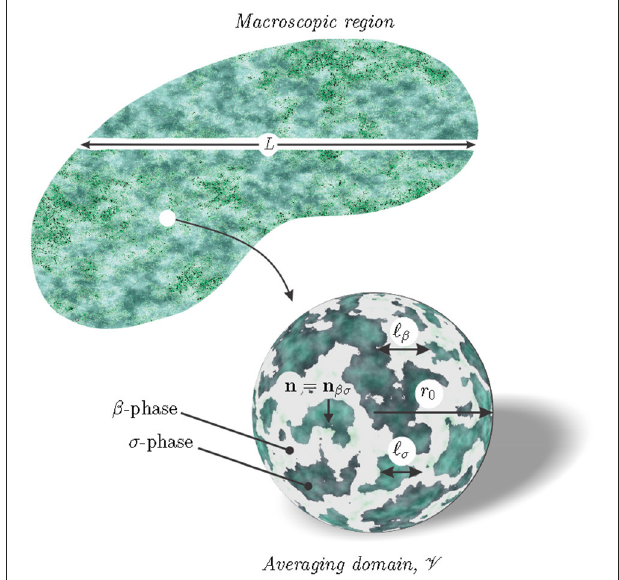
FIGURE 1 | Schematic representation of a porous medium system including the characteristic lengths at the microscale ( ℓ β in the β -phase and ℓ σ in the σ -phase), and at the macroscale ( L ) as well as the averaging domain of size r 0